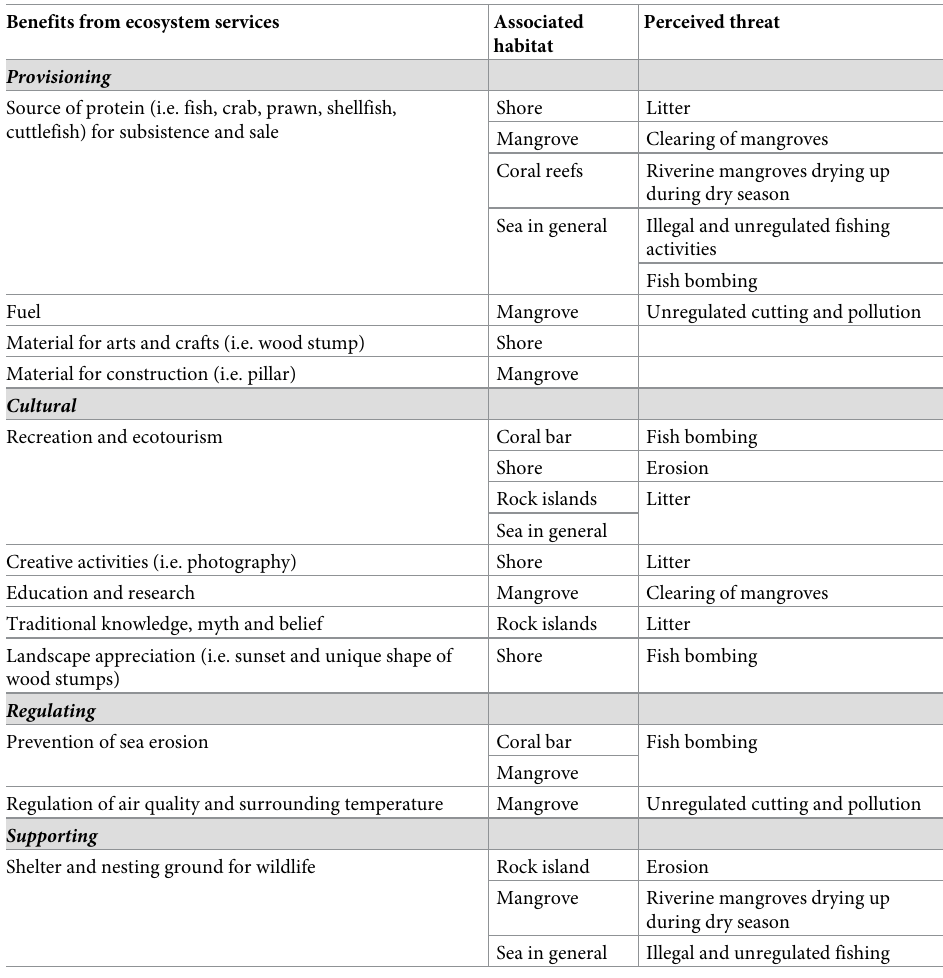
Table 3. Ecosystem services depicted by the photographs, accompanying captions and responses to questions by researchers during group discussion as resulted from the Photovoice activity. Note that the information for each ecosystem services provided by the participants should be considered as the benefits they received from the ecosystem